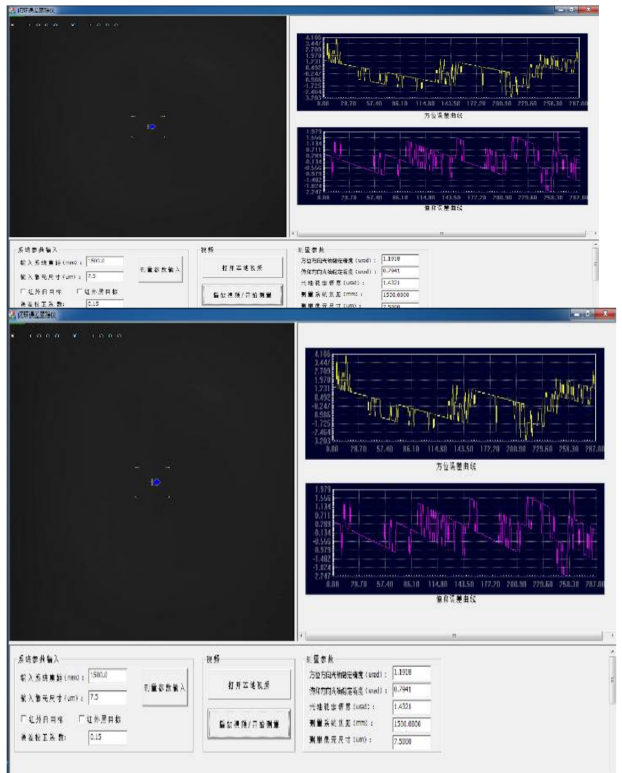
Figure 17. Image Analysis System.